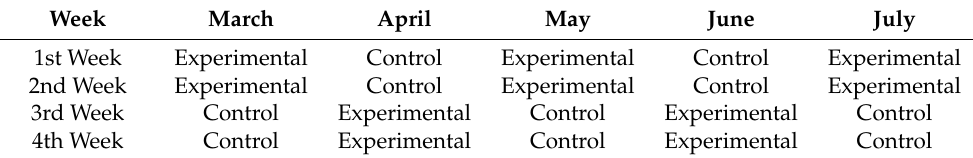
Table 1. Distribution of participants by the experimental and control groups.